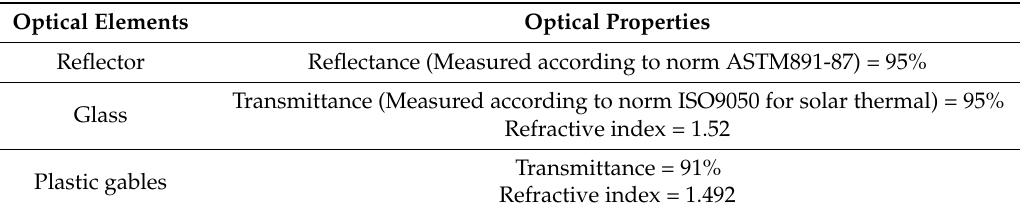
Table 1. Summary of the properties of optical